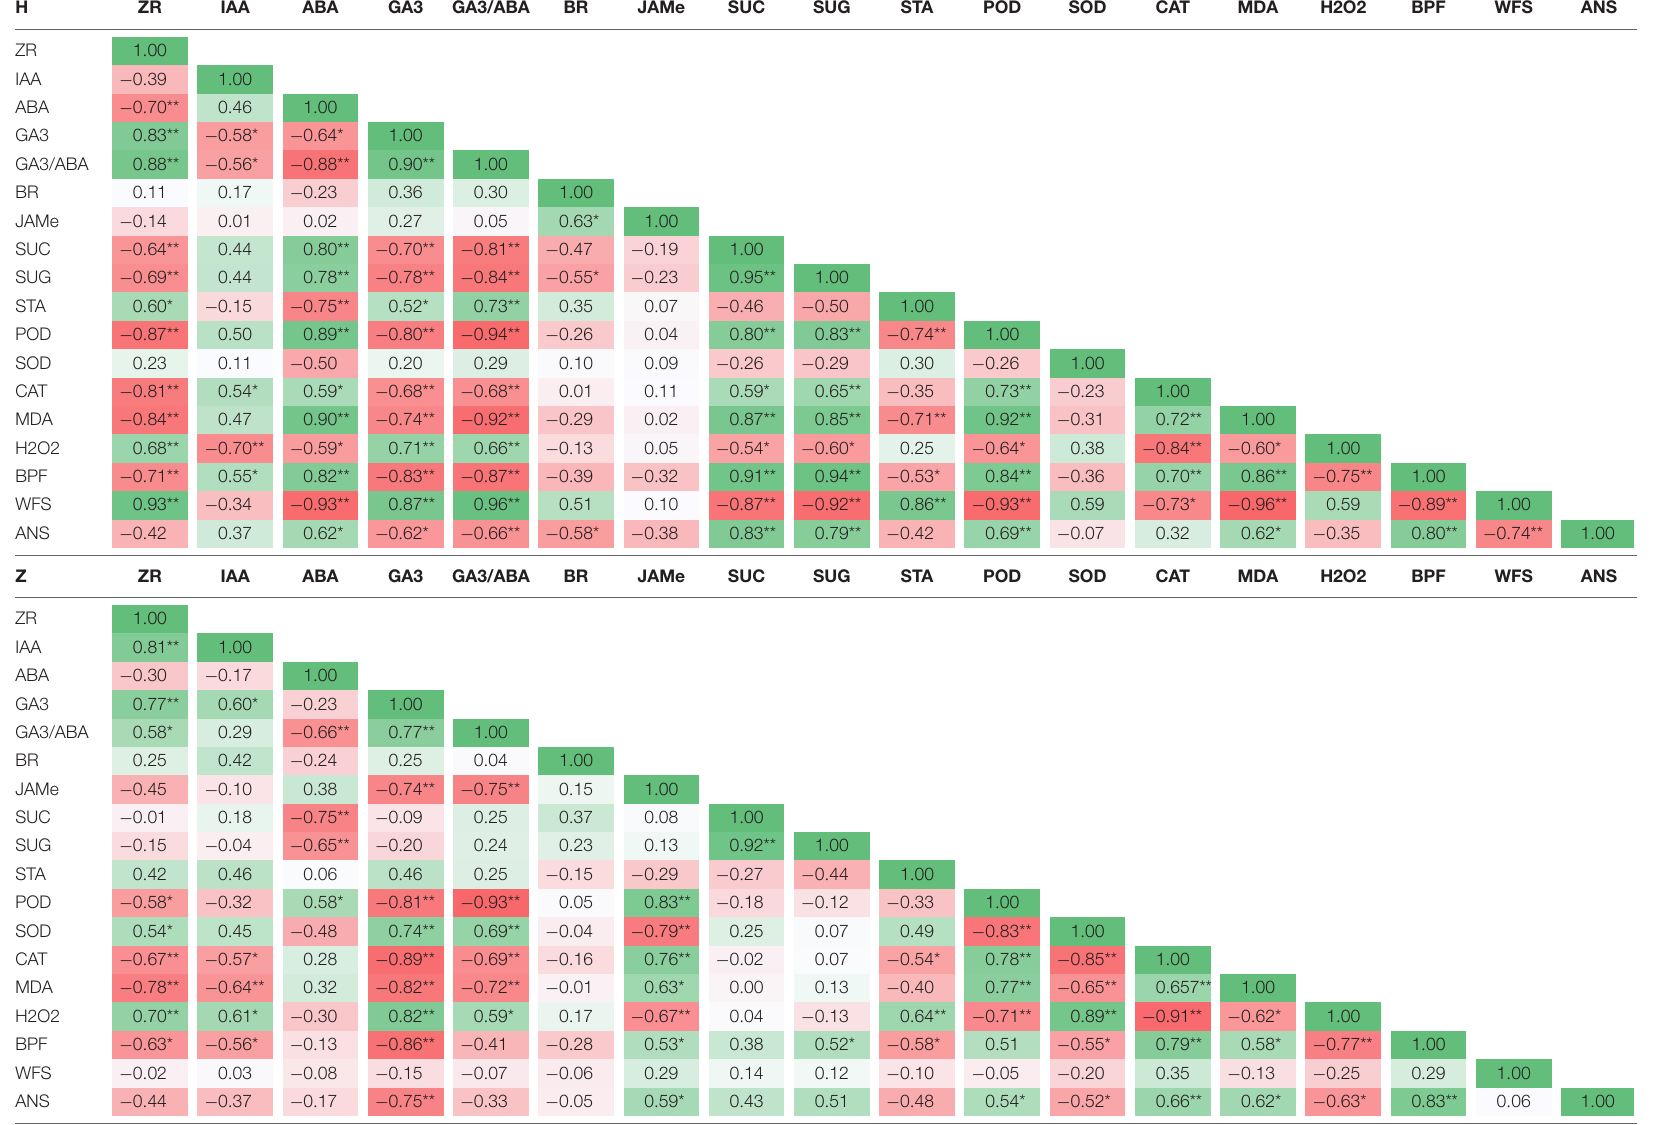
TABLE 4 | Correlation analysis of bud endodormancy release related crucial indices in the low-CR ‘Hang Baishao’ and high-CR ‘Zhuguang.’ H